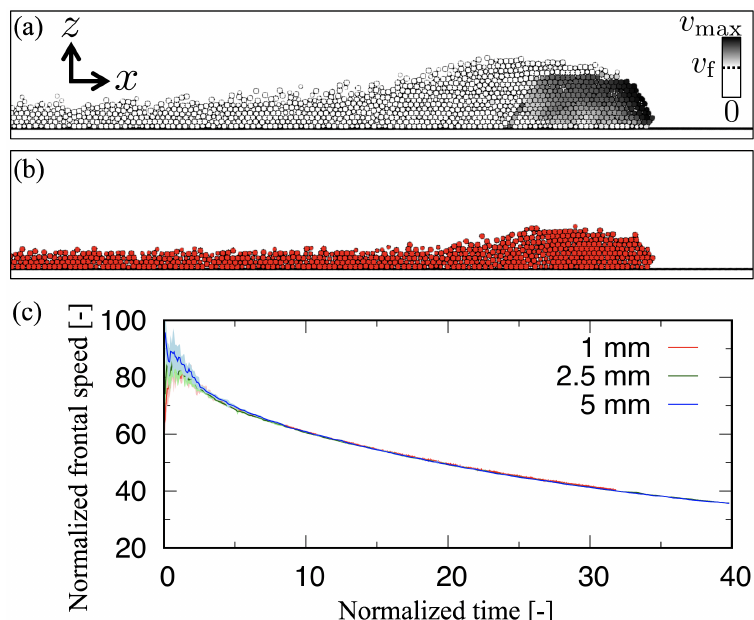
Figure 7. Formation of head–tail structure with a p = 5 mm in the triangular set-up: ( a ) ˜ t = 15.9, and ( b ) ˜ t = 39.8. ( a ) The gray scale denotes the x component of the particle velocity. The white particles are slower compared to the frontal speed v f , whereas the gray particles are faster compared to v f . Here, v f is calculated from the particle on the slope (i.e., the first layer). ( c ) Three normalized frontal speeds ˜ v f ( ˜ t ) are shown at a p = 1, 2.5, and 5 mm. The mean and standard deviation of 20 simulations are denoted by a solid curve and thin band,